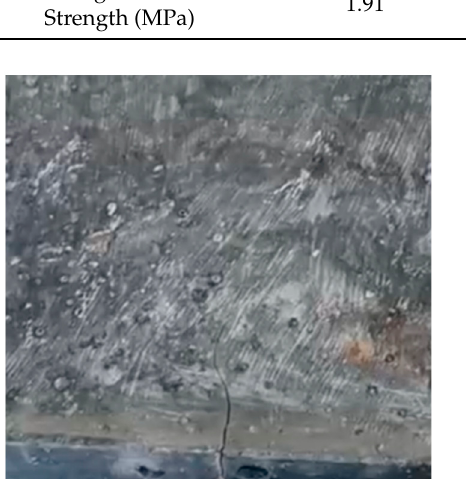
Figure 8. 30%DM ‐ 70%GGBS Pavement tile specimen image. Figure 8. 30%DM-70%GGBS Pavement tile specimen